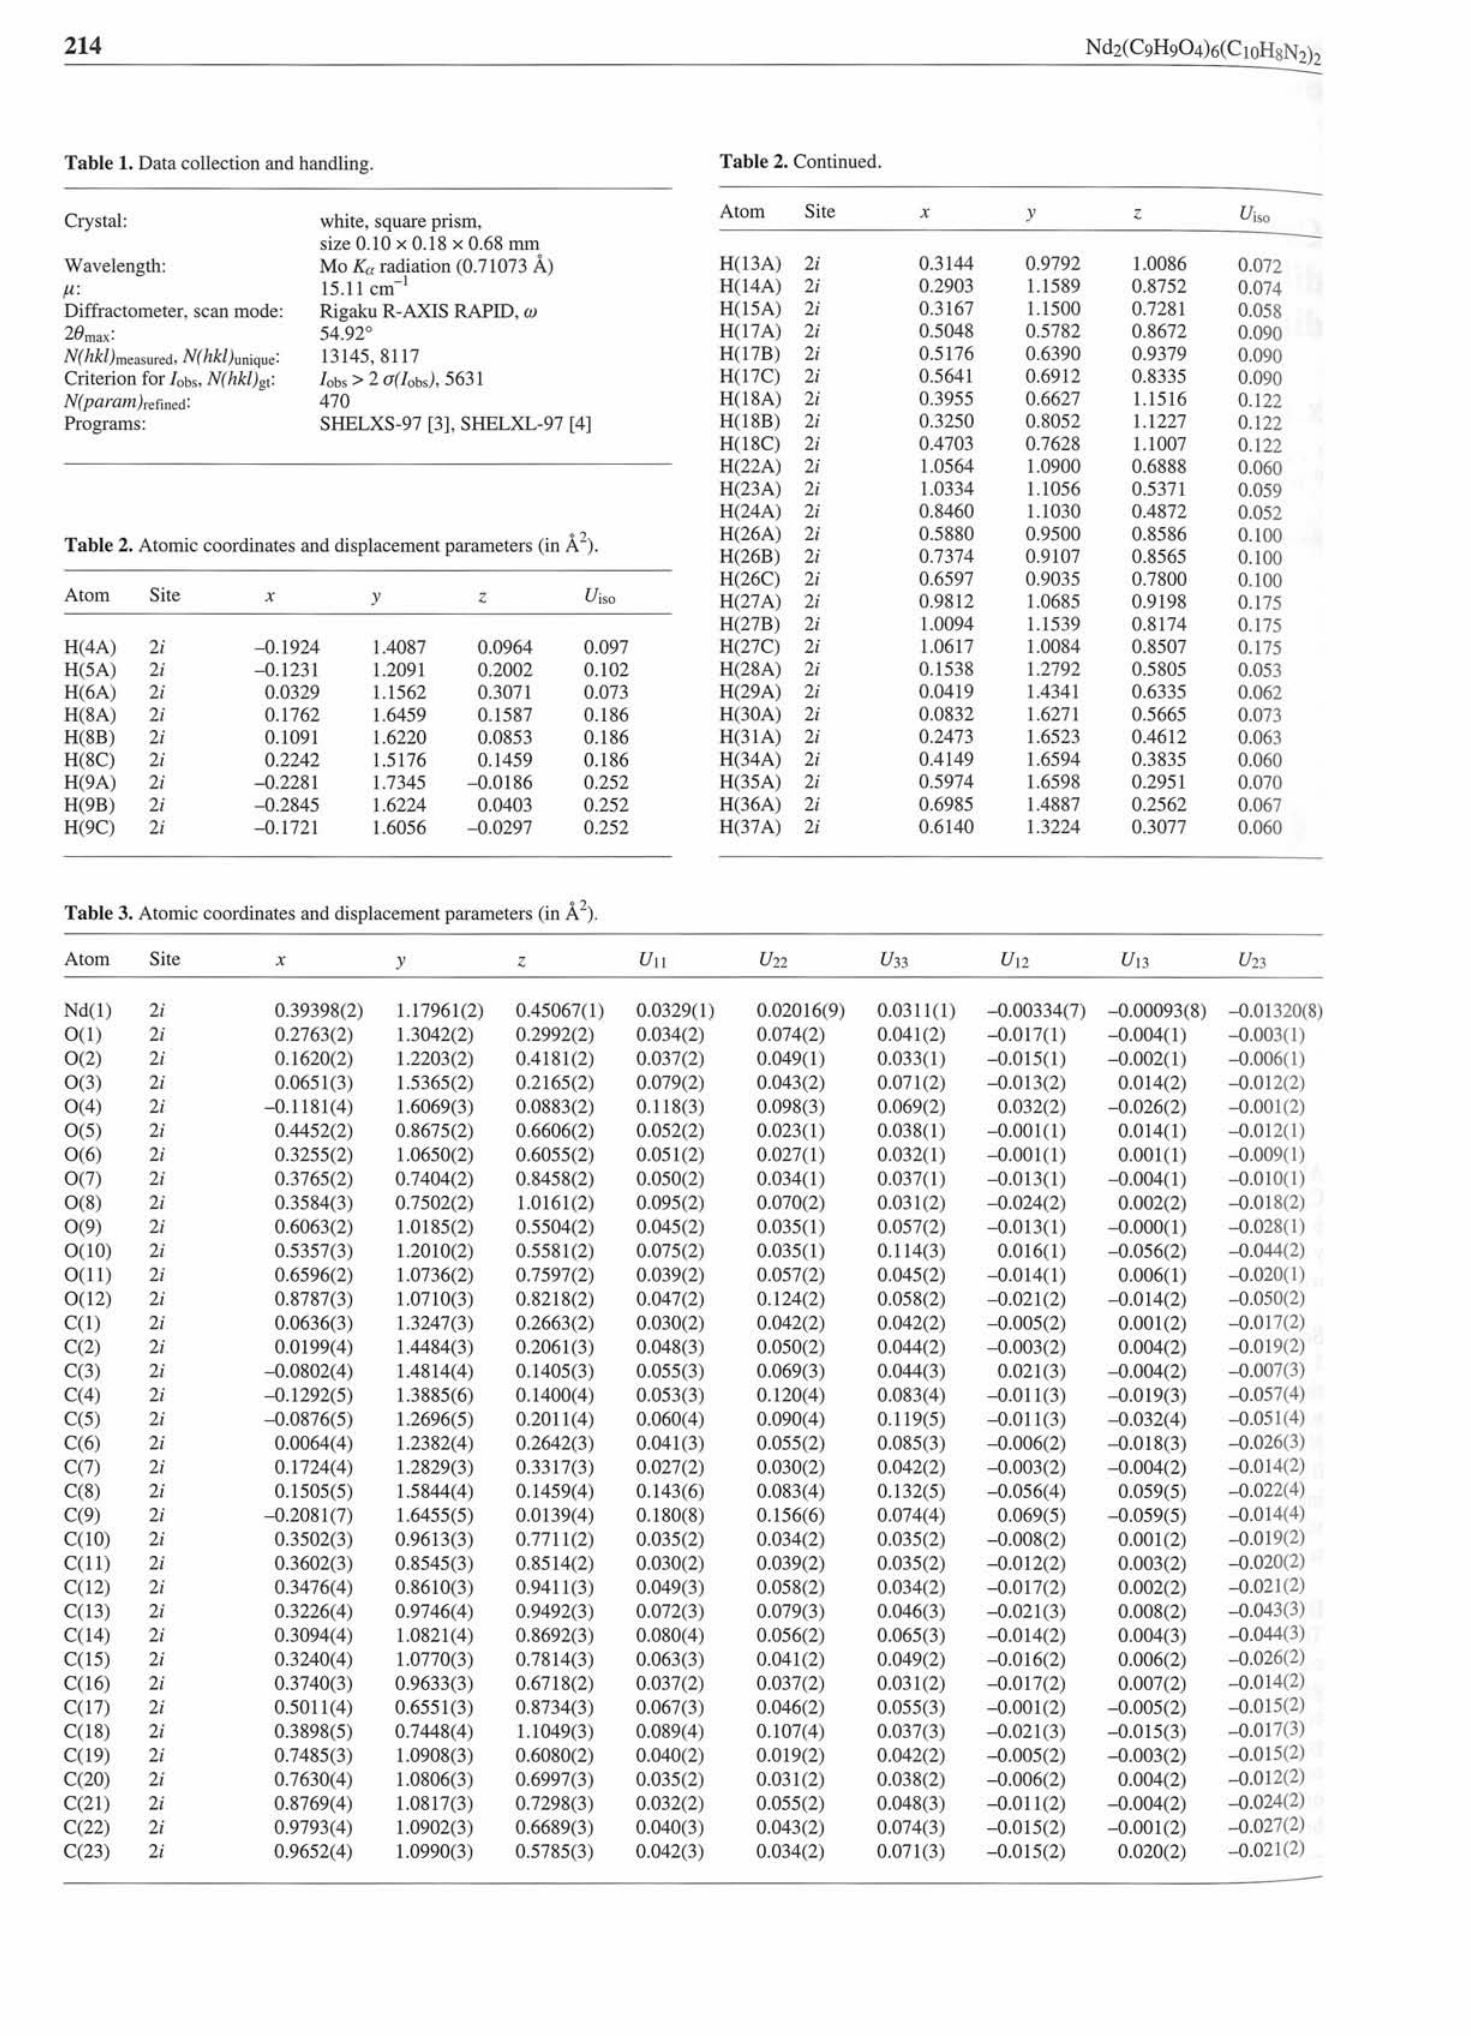
Table 2. Atomic coordinates and displacement parameters (in Â^).